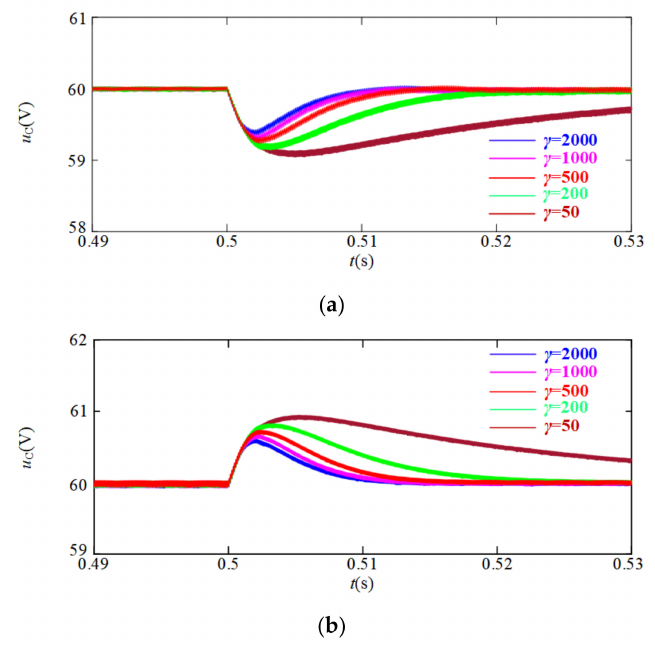
Figure 8. Simulated u C responses of the different γ when CPL steps up and down. ( a ) CPL: 60 W to 90 W; ( b ) CPL: 90 W to 60 W. Positive Damping Injecting and Conductance Injecting From (25), (30) and (31), the convergence rate of H P ( x E ) depends on g a and r a , and impacts on the dynamic response of the u C . The dynamic responses of the u C when the CPL steps from 60 W to 90 W and 90 W to 60 W at 0.5 s under different values of g a and r a ( g a = 1, r a = 2.12; g a = 2, r a = 4.24; g a = 3, r a = 6.36; g a = 4, r a = 8.48; g a = 5, r a = 10.6) are shown in Figure 9.